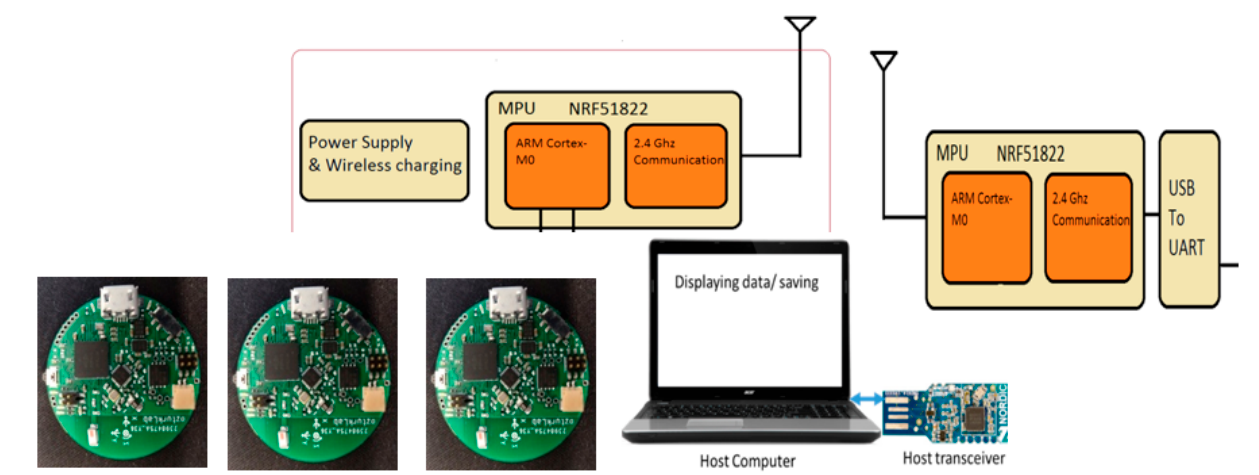
Figure 2. A custom designed IMU network to record lumbopelvic movements: the sensor system diagram and the manufactured wireless IMU sensor circuit that is in the size of a diameter of 23 mm.